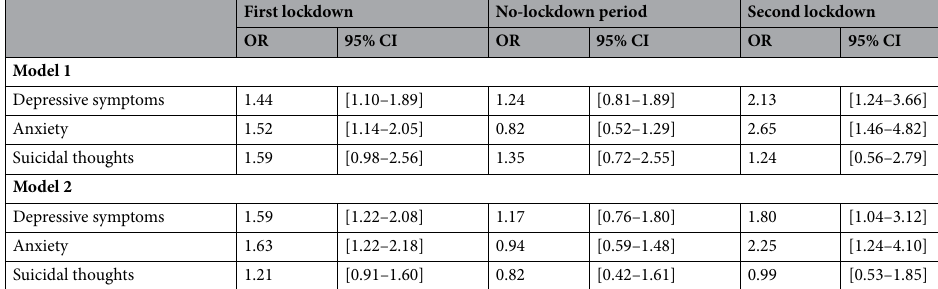
Table 2. Association between college student status and depressive symptoms (n = 3783), anxiety (n = 3783), suicidal thoughts (n = 3043) according to key periods of the COVID-19 epidemic in France, CONFINS study (2020–2021). Model 1 adjusted for age and gender; Model 2 adjusted for age, gender, psychiatric disease history, education level, marital status and after multiple imputation on psychiatric disease history. OR odds ratio, CI confidence